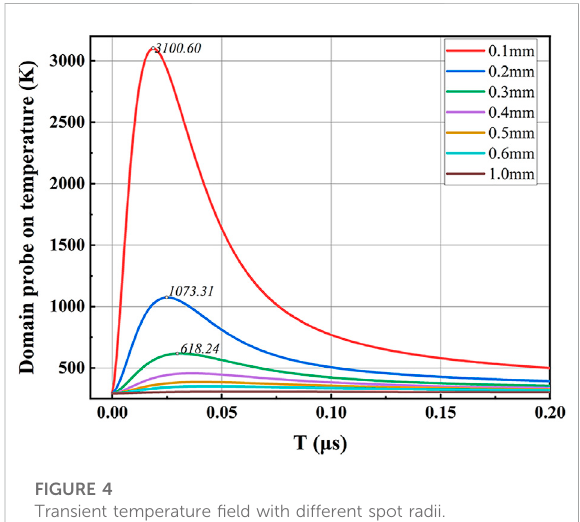
FIGURE 4 Transient temperature fi eld with different spot radii.